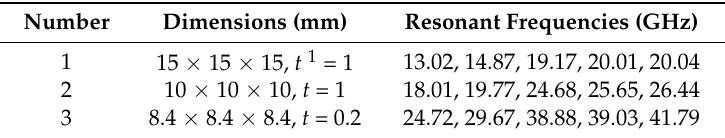
Table 2. Vapor cells with different sizes and their resonant frequencies obtained using eigenmode analysis. Number